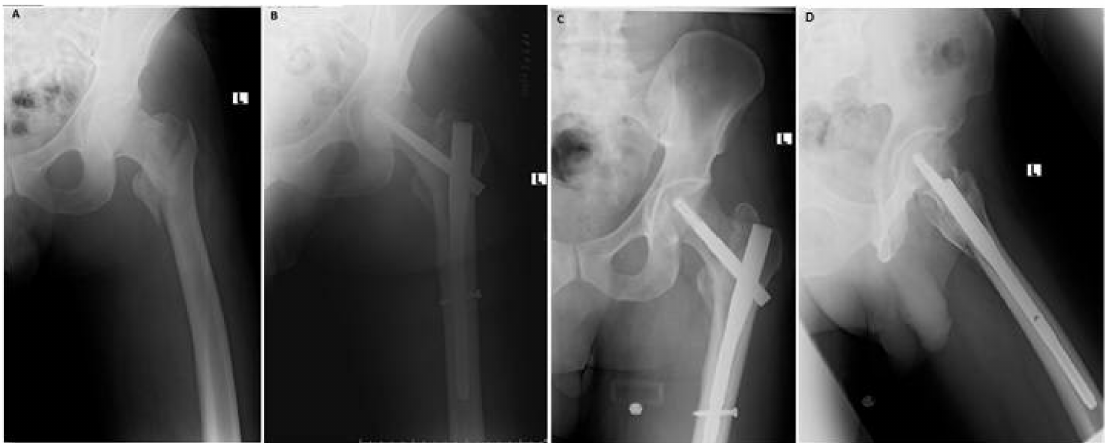
Figure 1. Type A2 fracture ( A ). Immediate postoperative AP radiograph showing a neck-shaft angle of 130 ◦ ( B ). The 6 months follow up AP radiograph showing a neck-shaft angle of 130 ◦ and union of the fracture ( C ). Lateral view at 6 months follow up ( D ).